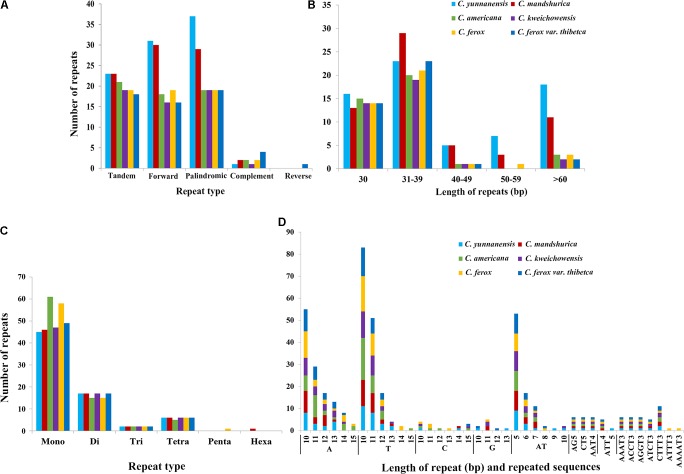
The type and distribution of repeated sequences and SSRs in the cp genome of six Corylus species. (A) Number of five repeat types; (B) Number of repeat sequences by length; (C) Number of six SSR types; (D) Number of identified SSR motifs in different repeat class types.